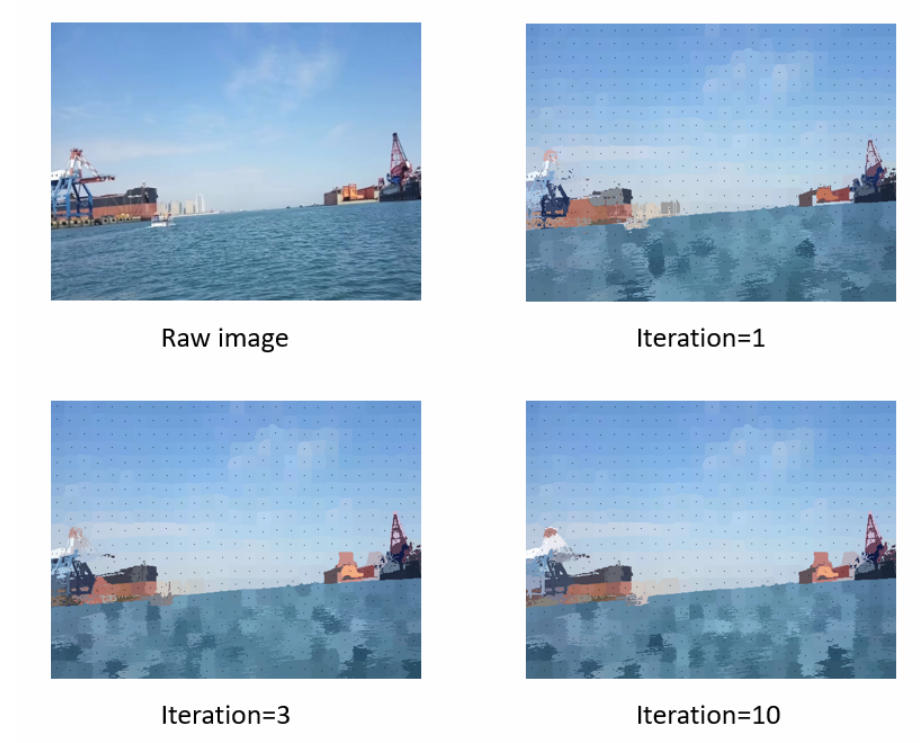
Figure 7. Output image at different iterations for K = 500, m =